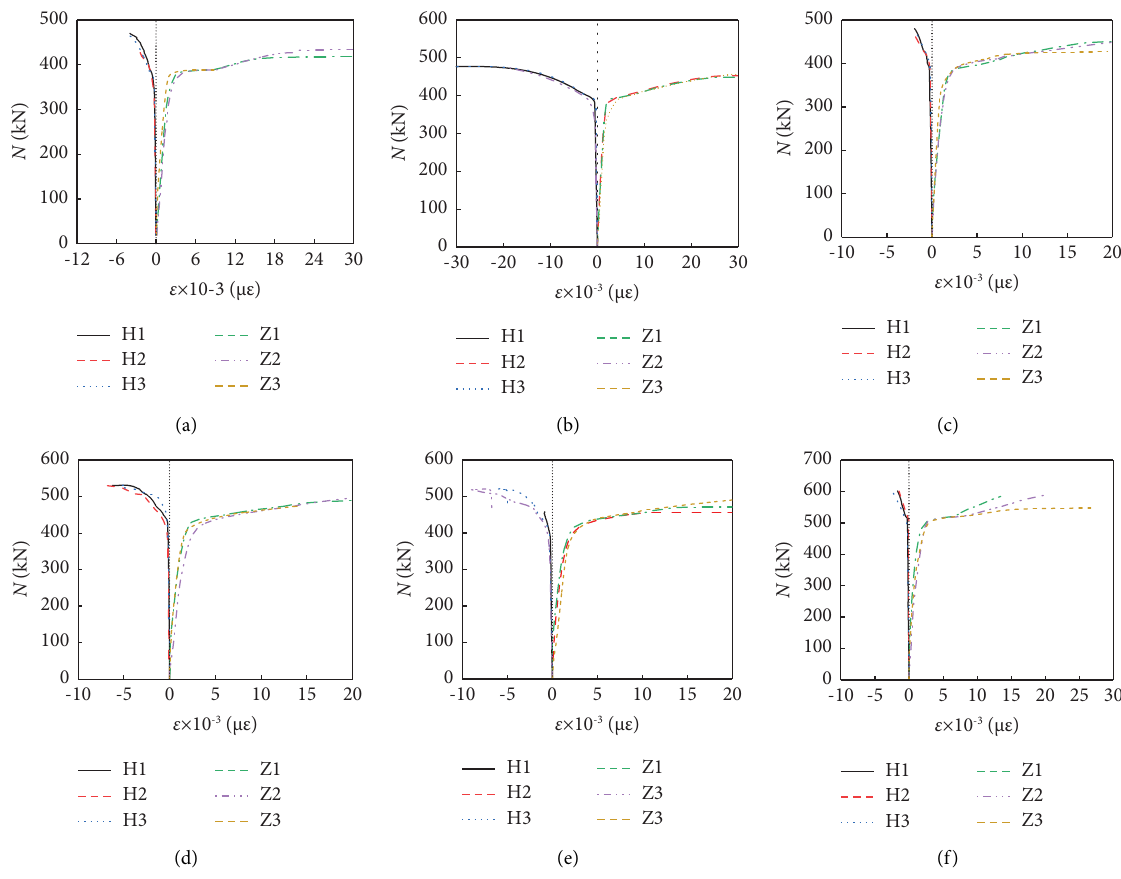
Figure 12: Flat section assumption: (a) 89-40, (b) 114-0, (c) 114-30, (d) 114-40, (e) 114-50, and (f) 139-40.